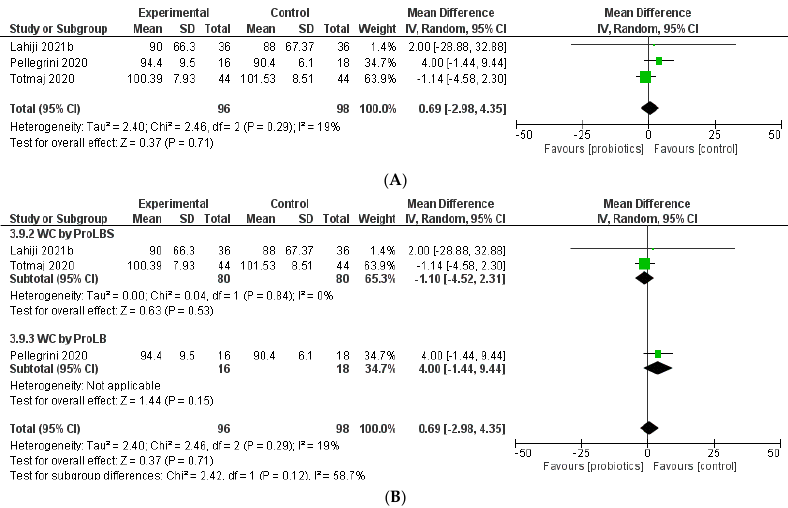
Figure 6. Meta-analysis for waist circumference (WC) ( A ) and WC by probiotics type ( B ).